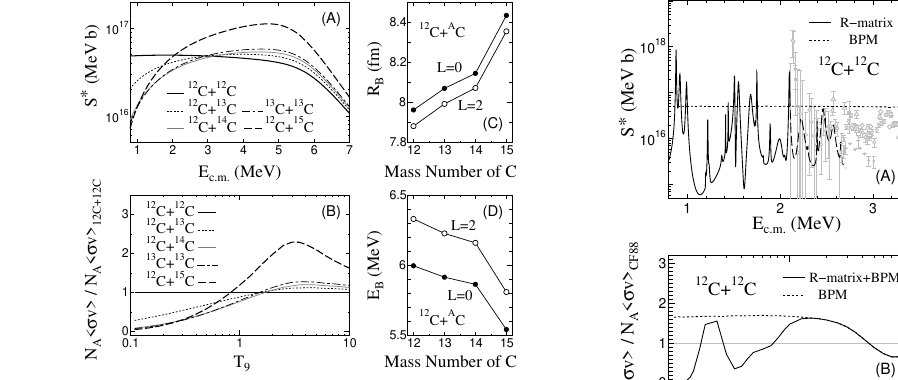
Figure 2. Isotope dependence of (A) S ∗ , (B) reac- tion rates, (C) R B , and (D) E B , obtained from BPM. (A,B) The curves are the results for the respective system shown in figure. (C,D) R B and E B are ob- tained from ˜ U L . The solid and open circles are the values for L = 0 and L = 2, respectively.